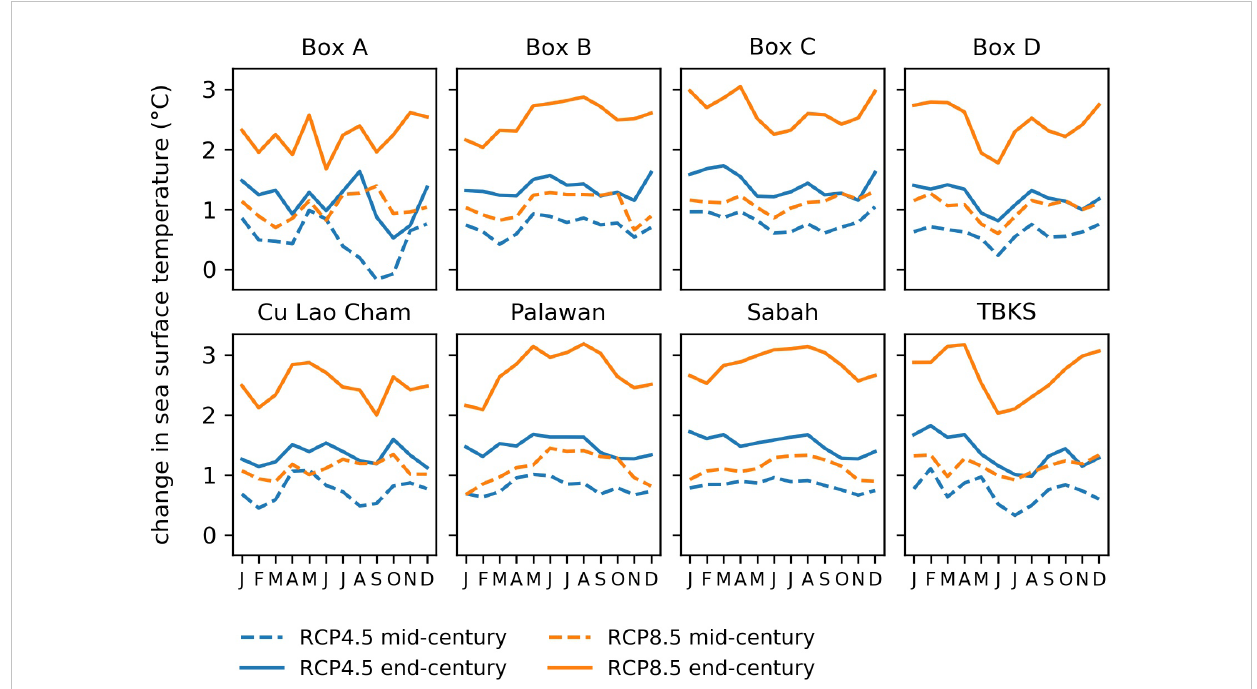
FIGURE 4 Projected change in monthly mean sea surface temperature compared to present day for 8 sample areas, for mid-century (dashed lines) and endcentury (solid lines). Blue lines show RCP4.5 and orange lines RCP8.5. Temperatures are averaged over 20-year time periods:2000-2019, 2040- 2059 and 2079-2098. See Figure 1 for sample area